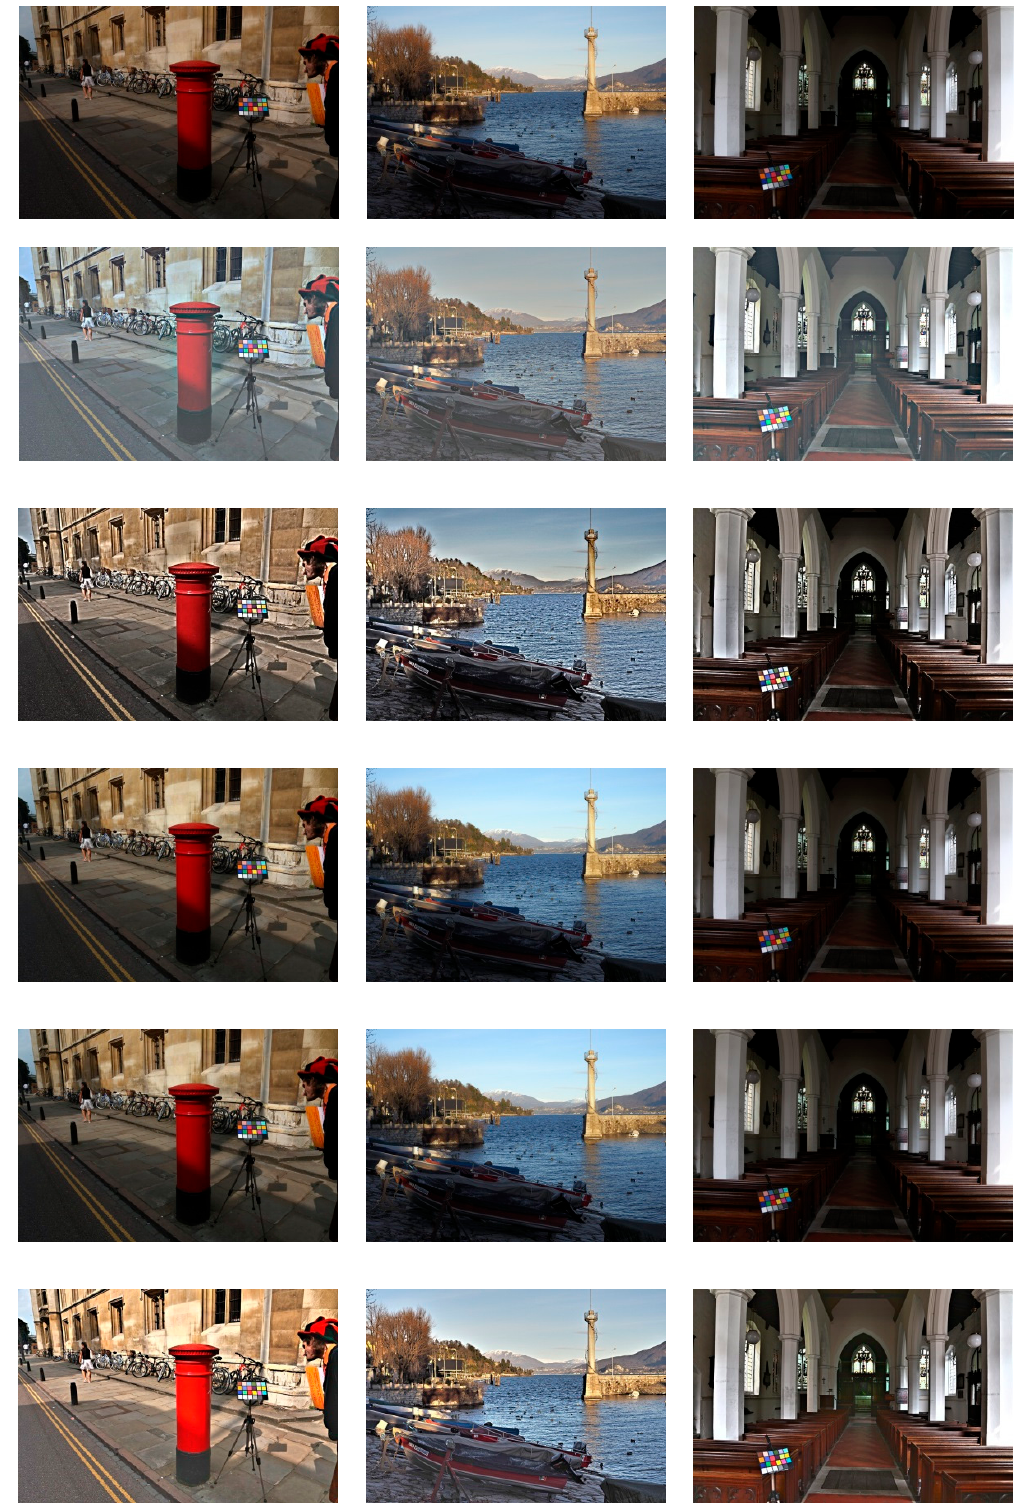
Figure 4. Visual comparisons with A1, A5 and A12 test images: (from top to bottom) low-light image, MSR, AMSR, RSR, LRSR, and proposed method.